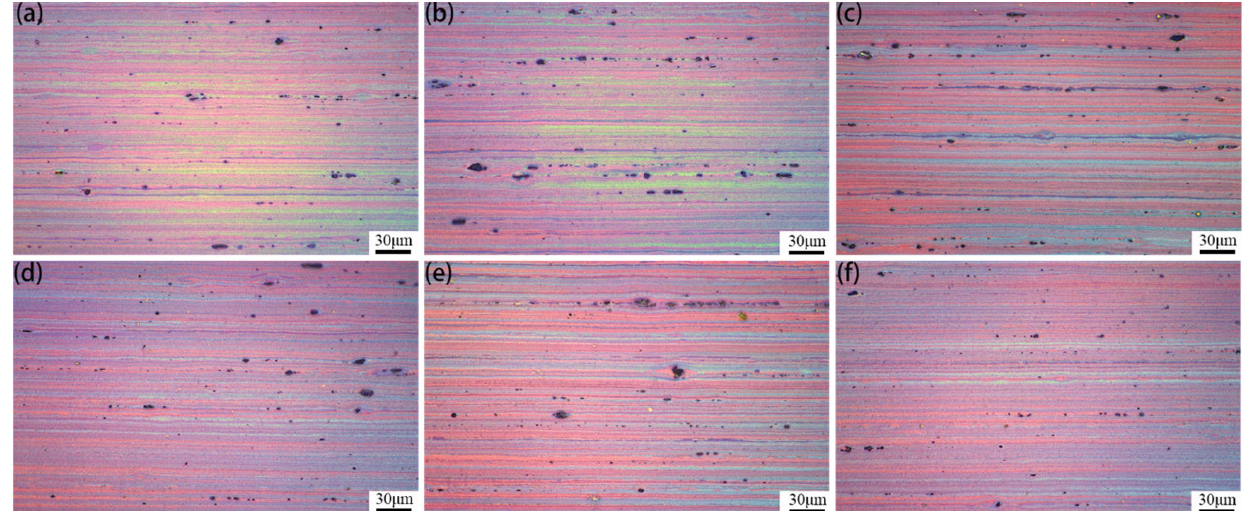
Figure 3. Grains of 7005 aluminum alloy plates aged at 120 °C for different durations (along the longitudinal section, after anodic coated by 1% HF + 1% HBF 4 + 24% C 2 H 5 OH + 74% H 2 O): ( a ) 1 h, ( b ) 4 h, ( c ) 12 h, ( d ) 24 h, ( e ) 96 h, and ( f ) 192 h.